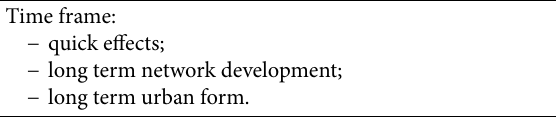
Table 4. Attributes and political considerations used for setting weights on design